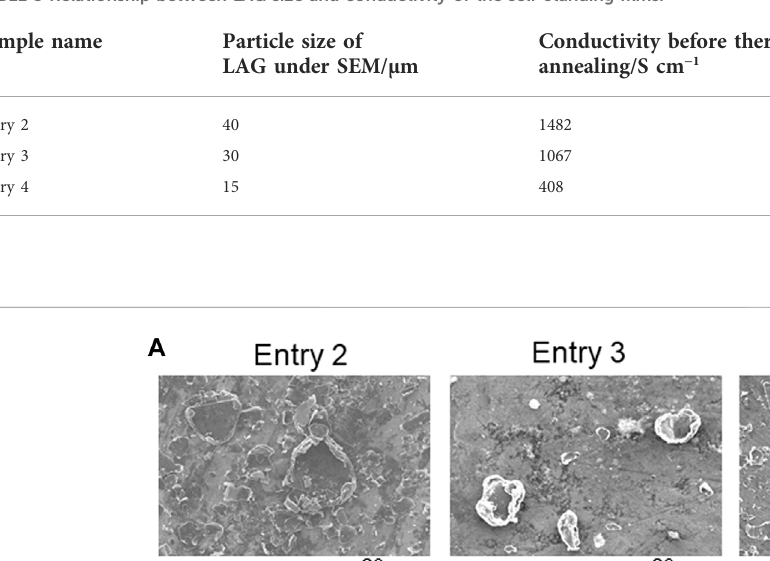
TABLE 3 Relationship between LAG size and conductivity of the self-standing fi